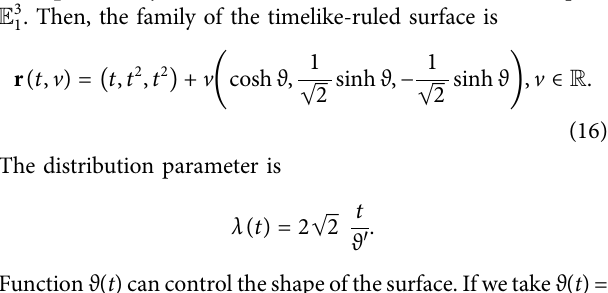
FIGURE 4 | Timelike-ruled surface, with ϑ ( t ) = t